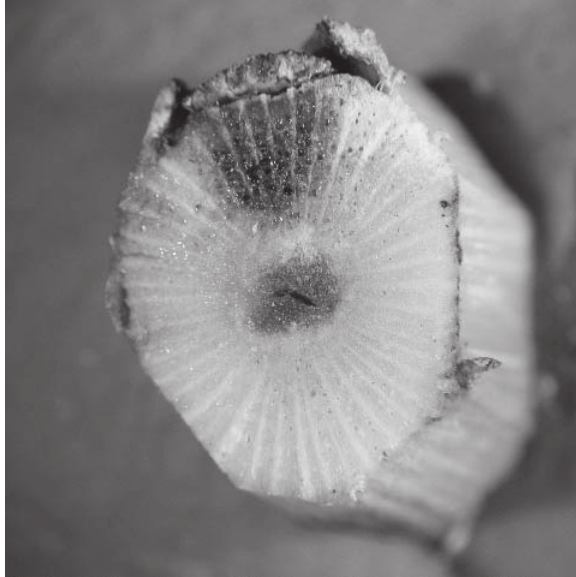
Fig. 3. Cross section of a cane inoculated with Cryptoval- sa ampelina CBS 117486 showing a necrosis extending from the inoculation